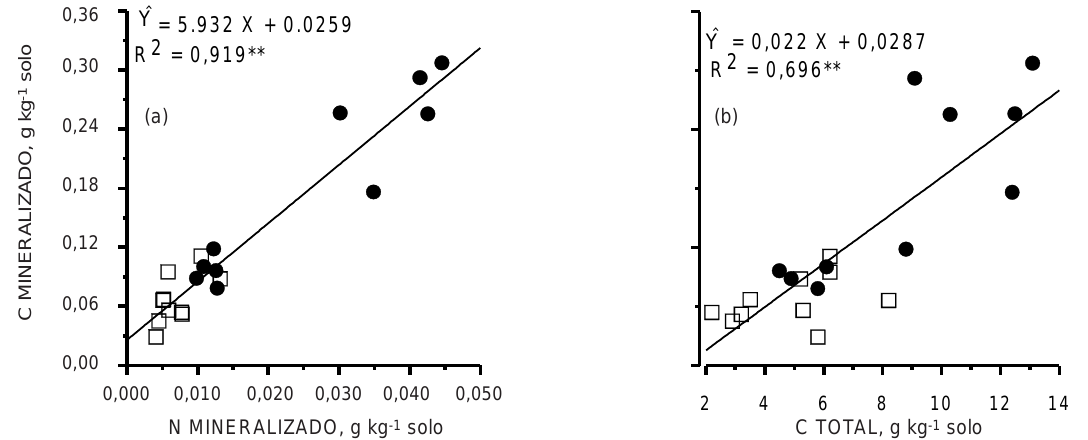
Figura 6. Relação entre os valores de C e de N mineralizados em 4 semanas de incubação (a) e de C mineralizado e de C total (b), em amostras das camadas de 20-40 cm de solos da zona úmida (círculos) e da zona semi-árida (quadrados) de Pernambuco.